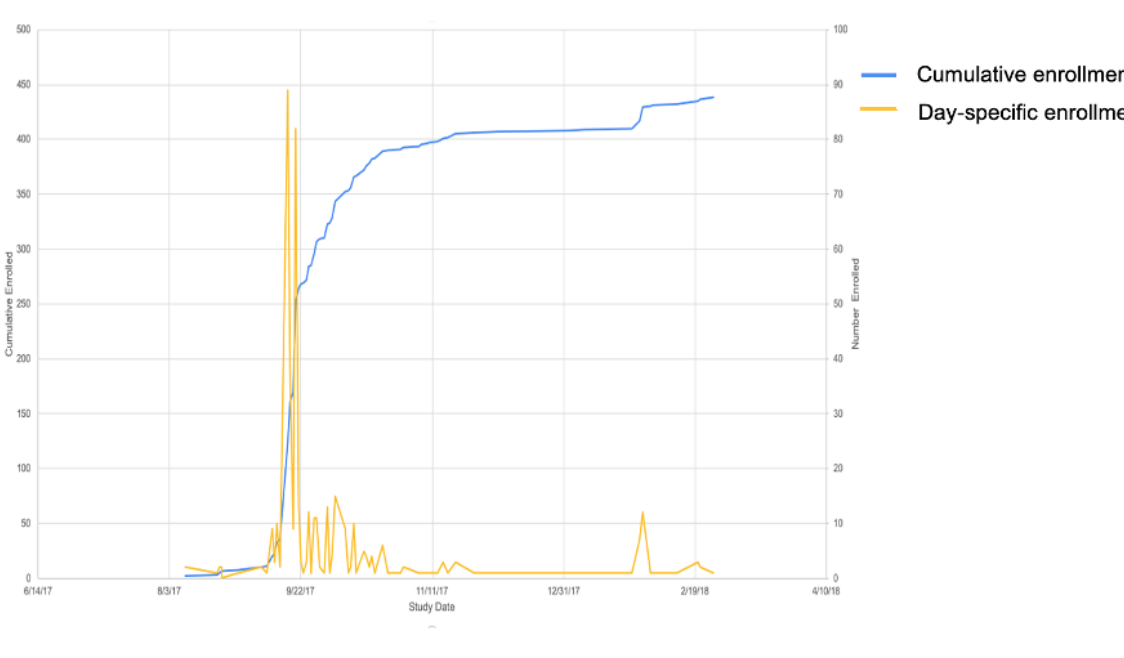
Figure 2. Ovulation and Menstruation Health Pilot Study enrollment